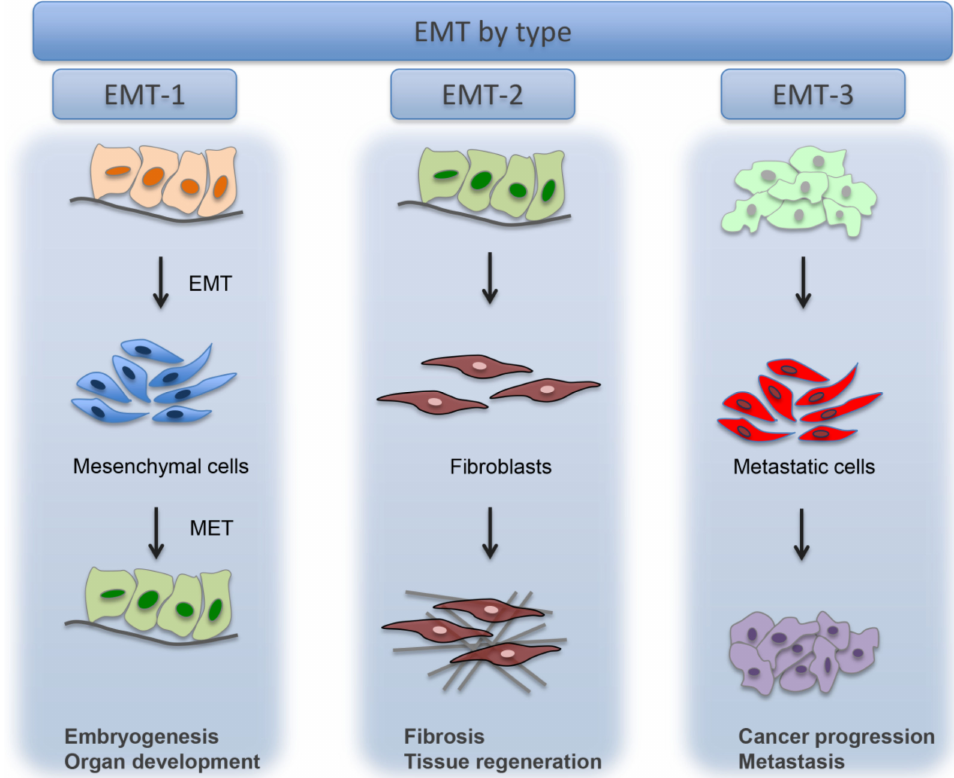
Figure 1. Types of EMT. Type-1 EMT, Type-2 EMT, Type-3 EMT. Reprinted from Zeisberg, M.; Neilson, E.G. Biomarkers for epithelial-mesenchymal transitions. J. Clin. Invest. 2009 , 119 , 1429–1437